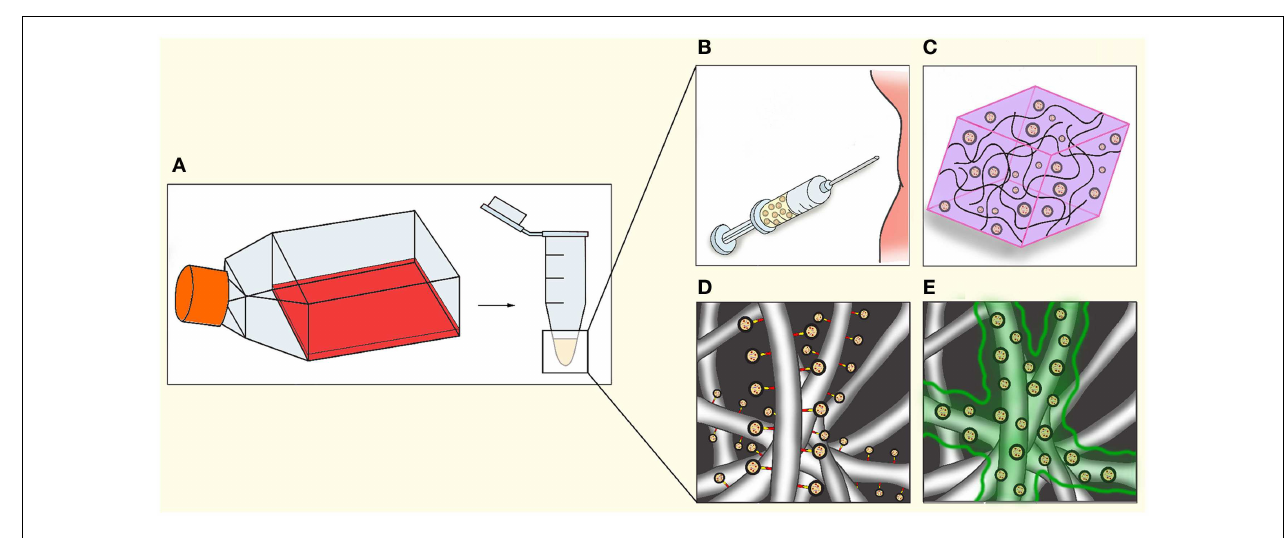
in hydrogels. (D) Coating electrospun fibers indirectly via chemical linkers, antibodies, or specific tags engineered on to the EV. (E) Coating of electrospun fibers with bio-degradable gels such as fibrin, resulting in gradual release during gel